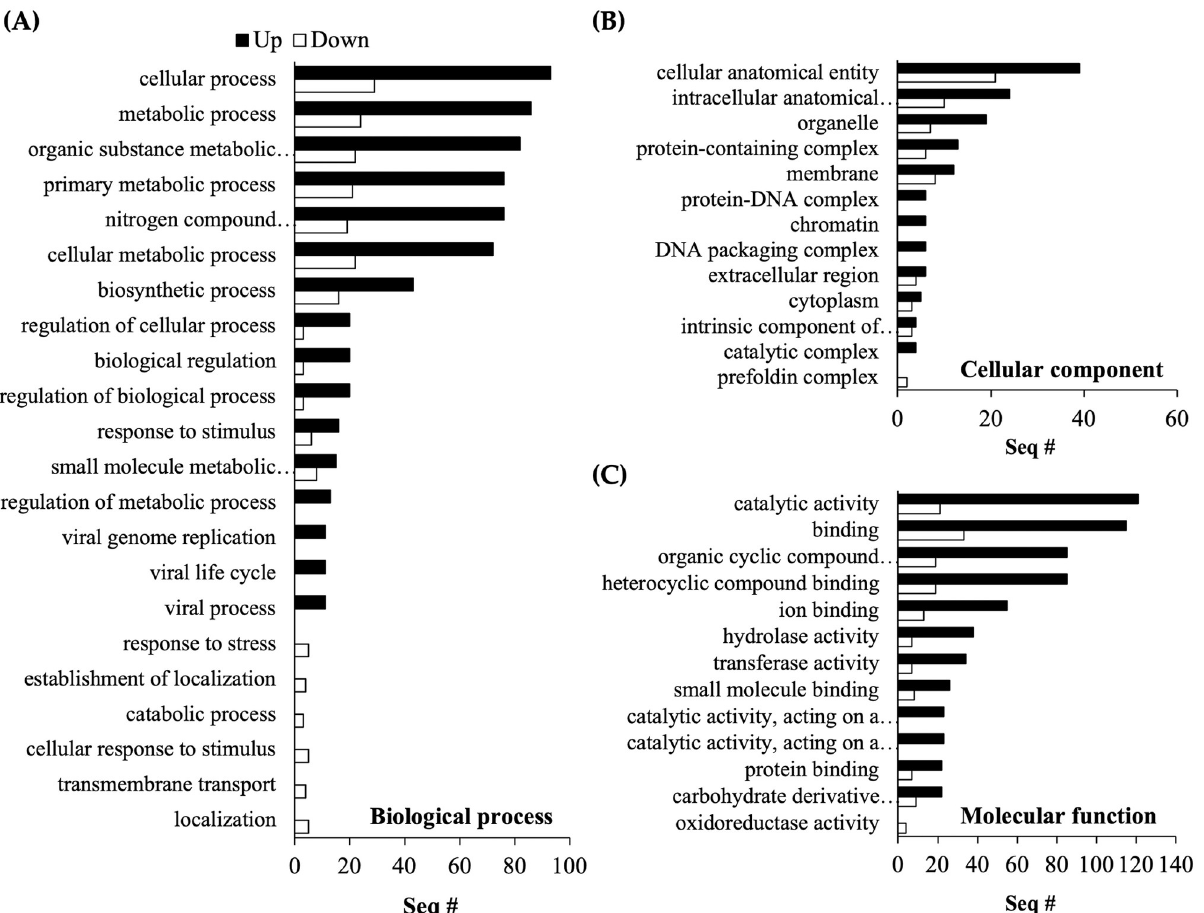
Fig 3. Gene ontology (GO) analysis of red mite DEGs. Gene Ontology (GO) analysis of non-treated control red mites vs. fungal-infected red mites was conducted. The up- and down-regulated genes were annotated to a biological process (86 and 3), a cellular component (13 and 21), and molecular function (115 and 21). DEGs of fungal-infected red mites were annotated in three GO groups: (A) biological process (32.7%), (B) cellular component (14.3%), and (C) molecular function